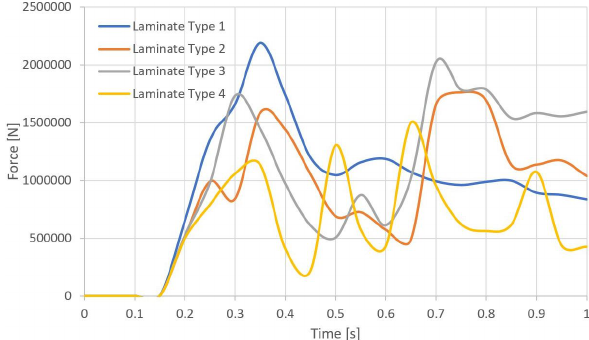
Figure 35: Force – Time of each type of laminate based on the im- pact at a speed of 5